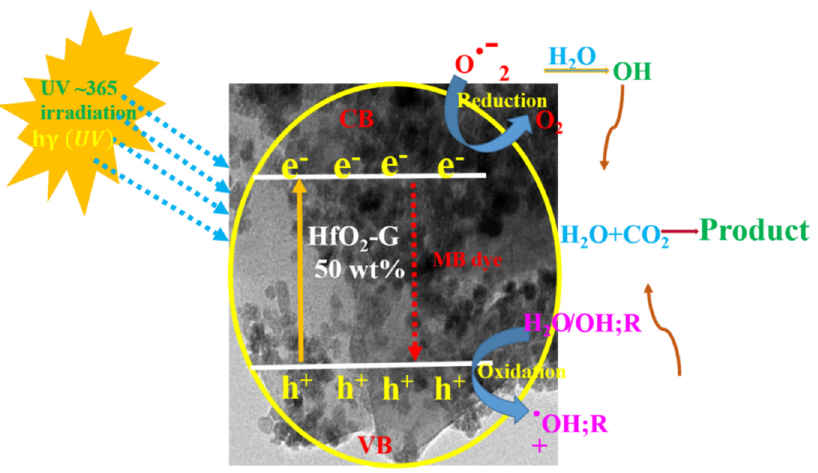
Figure 10. Proposed reaction mechanism for the photocatalytic dye degradation of MB dye by HfO 2 -graphene (50 wt%) nanocomposites under UV illumination.